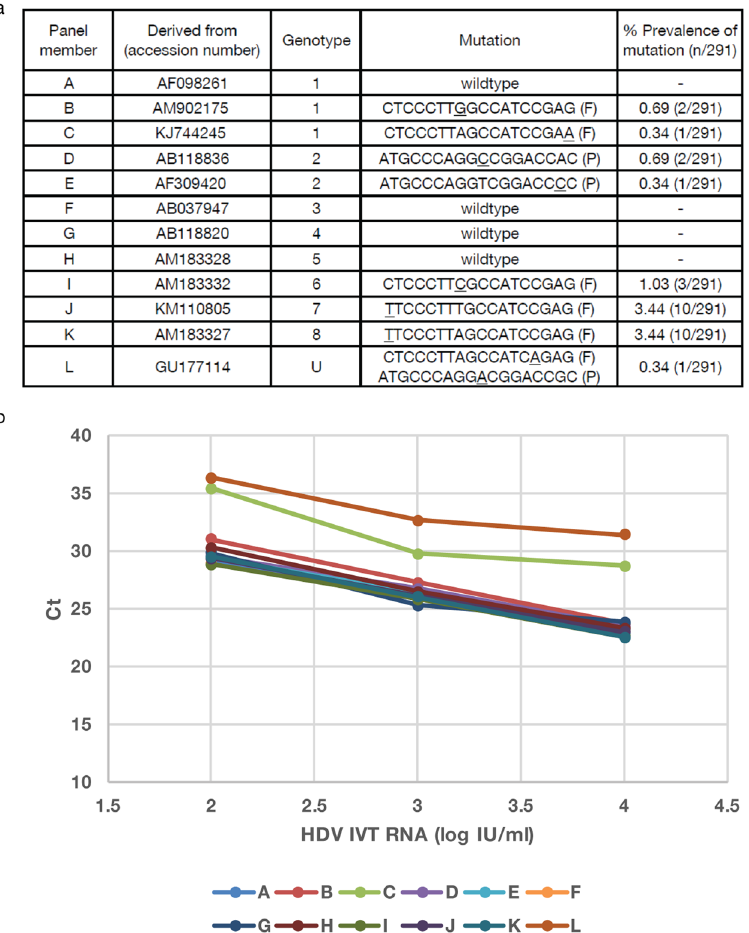
Figure 2. Evaluation of mutation challenge panel in molecular assay. A. In vitro transcribed RNA mutation panel. Indicated are the Genbank accession numbers, genotype, and mutations in each in vitro transcribed RNA. Frequency of mutation in the 291 sequences analyzed is represented by percent prevalence of mutation. U: unclassified, F: forward primer, P: probe. B. In vitro transcribed RNAs were diluted from 10 4 to 10 2 IU/ml and tested in the HDV molecular assay. Samples were tested in triplicate for each dilution and the average Ct value was plotted for each panel member.